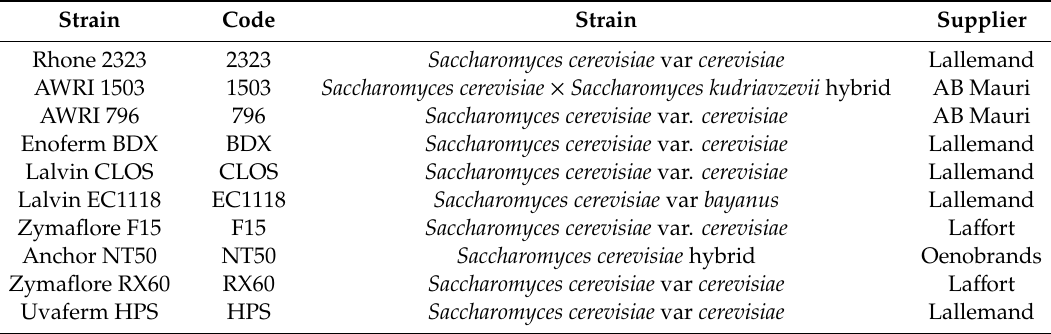
Table 1. Commercial Saccharomyces cerevisiae strains and their hybrids, used for Shiraz